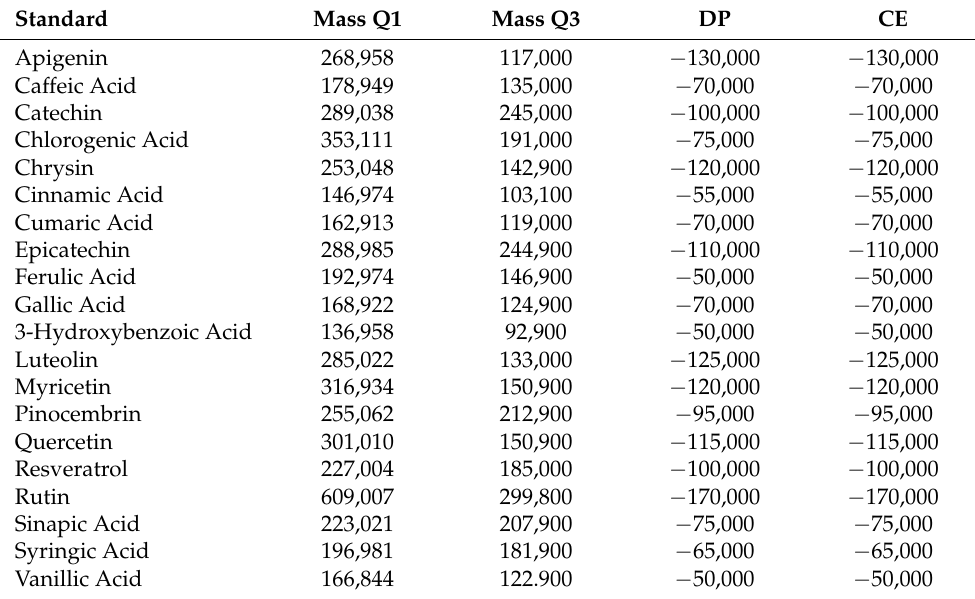
Table 3. MS/MS data for the identification of compounds in Argylia radiata